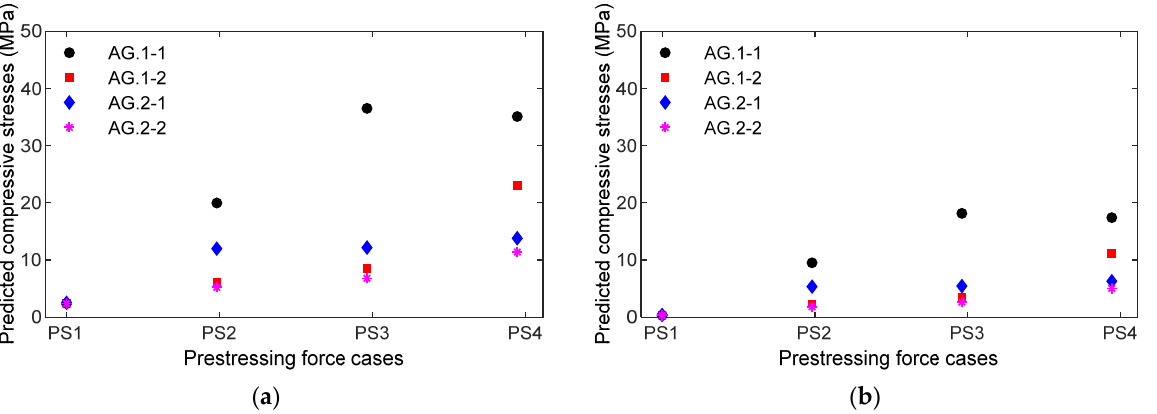
Figure 26. Predicted compressive stresses via measured impedance signatures for loading cases PS1~PS4: four smart aggregates AG.1-1~AG.2-2: ( a ) FEM estimation using the empirical equation; ( b ) Experiment prediction.